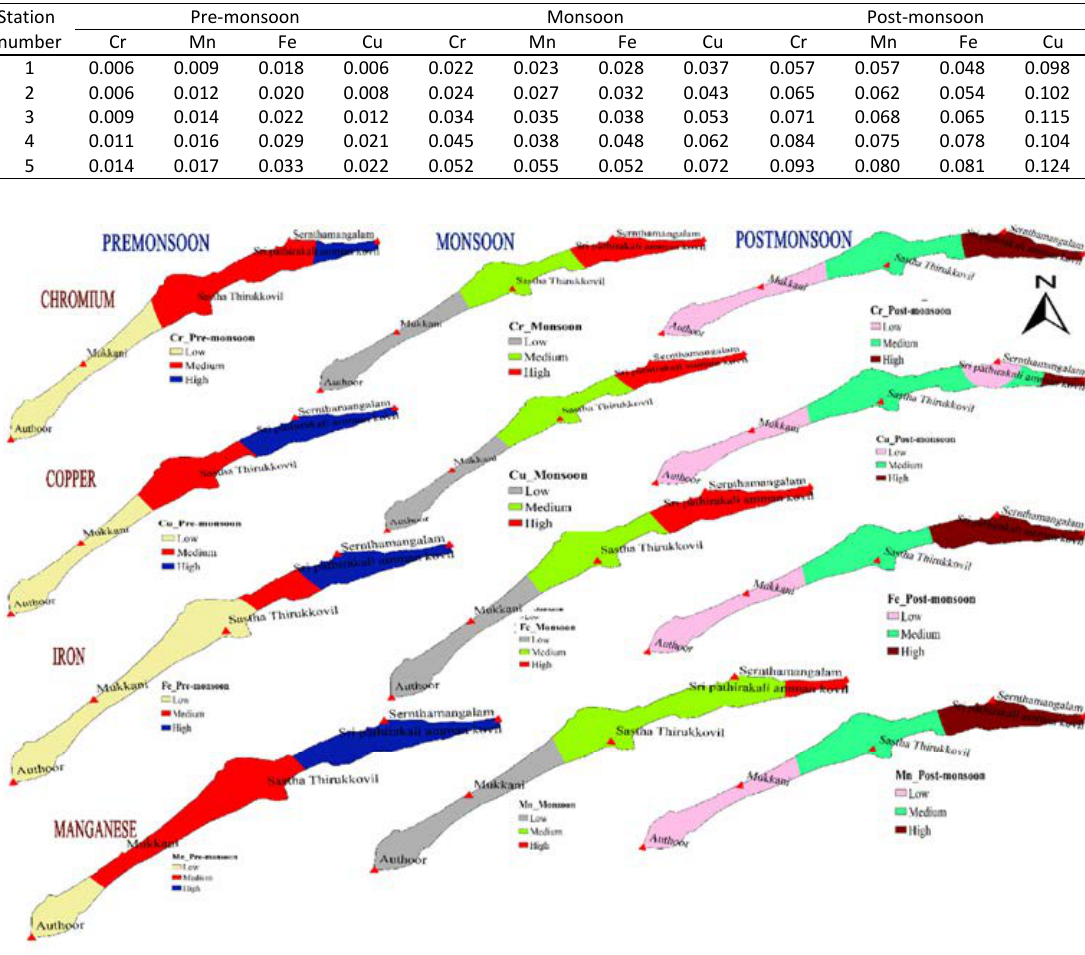
Fig. 4: Contamination factor of Cr, Cu, Fe, and Mn in sediments